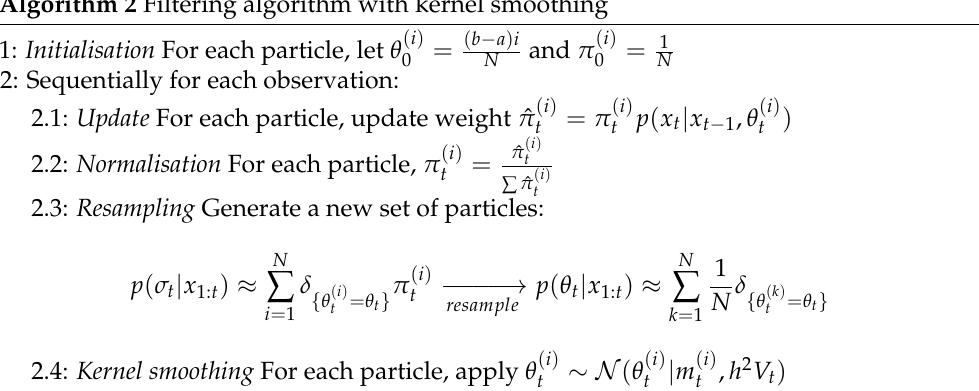
Algorithm 2 Filtering algorithm with kernel